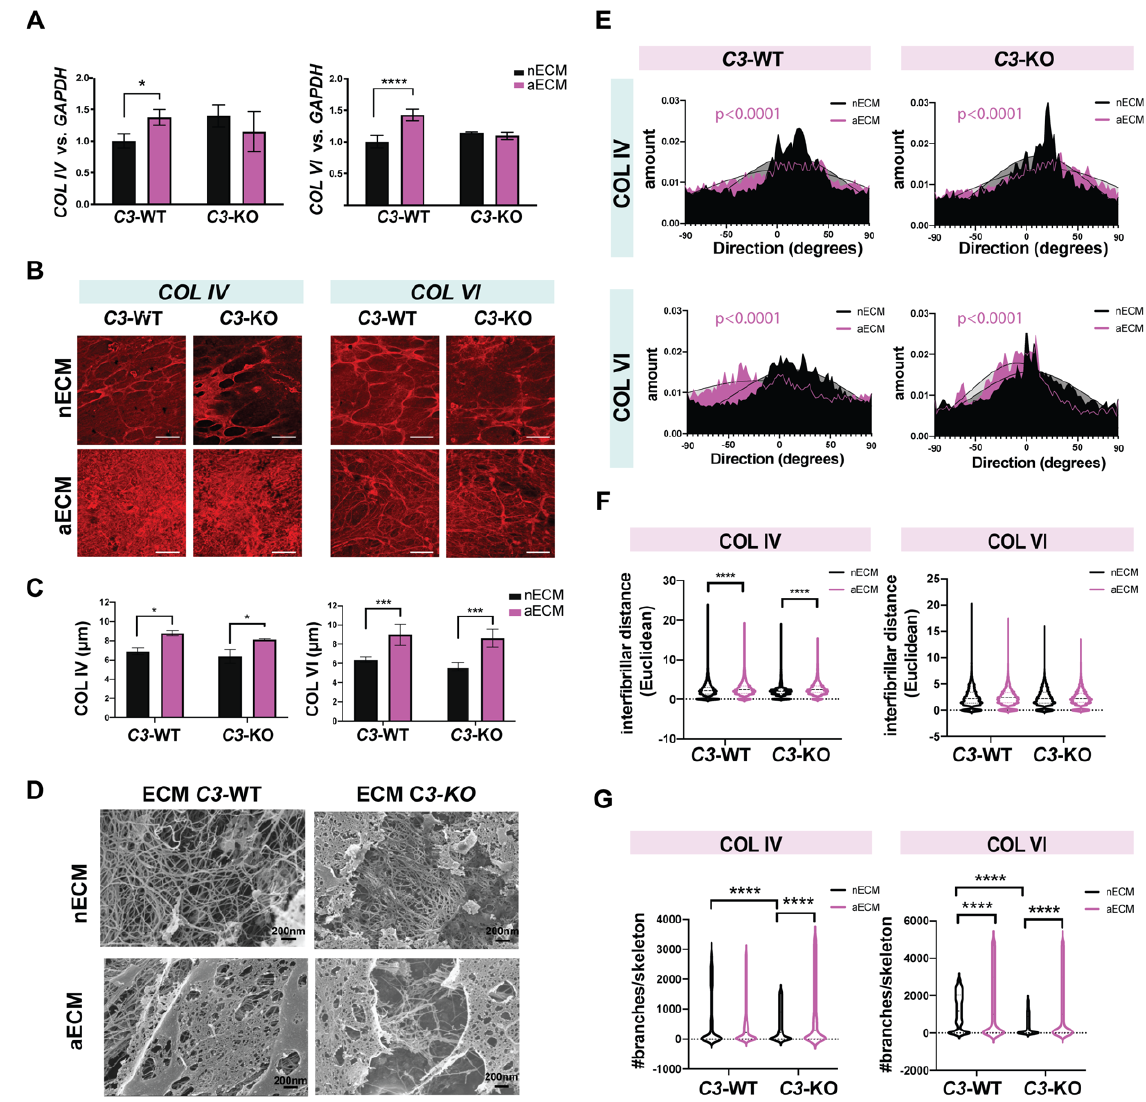
Figure 6. AMD-like substrate impairs the formation of the collagen meshwork. ( A ) mRNA levels of COL IV and COL VI normalized to GAPDH measured in iPSC-RPE cultures C3 WT/WT and iPSC-RPE C3 KO/KO grown on transwells coated with nECM and aECM for 20 weeks. ( B ) Representative confocal fluorescent microscopy images: top panels show the expression of collagen IV and collagen VI in iPSC-RPE cultures C3 WT/WT and iPSC-RPE C3 KO/KO after 20 weeks on transwells coated with nECM. Bottom panels show the extracellular deposition of COL IV and COL VI in decellularized transwells of iPSC-RPE cells C3 WT/WT and C3 KO/KO grown on AMD-like ECM (aECM) for 20 weeks. Scale bar: 25 µ m. ( C ) Thickness of collagens layers were measured with confocal using 0.13 µ m planes and are plotted in the graphs. Data represented as mean ± SD. N = 3 replicates, 2-way ANOVA, * p < 0.05, *** p < 0.001. ( D ) Scanning electron micrographs of the ECM deposited by iPSC-RPE cells C3 WT/WT and C3 KO/KO cultured on nECM and aECM after 20 weeks. ( E ) Directionality of the collagen fibers of representative immunofluorescent images was plotted. Gaussian distributions of cultures on nECM (black) and aECM (pink) were compared using their best fit values in a linear regression and are indicated in the graph with a black line. Distribution was significantly different between substrates for both genotypes (COL IV: C3 WT/WT nECM vs. C3 WT/WT on aECM, p < 0.0001; C3 KO/KO nECM vs. C3 KO/KO on aECM, p < 0.0001; COL VI: C3 WT/WT nECM vs. C3 WT/WT on aECM, p < 0.0001; C3 KO/KO nECM vs. C3 KO/KO on aECM, p < 0.0001). ( F ) The interfibrillar Euclidean distance (tortuosity) was measured for COL IV and COL VI fibers using FIJI and the BoneJ plugin. (One-way ANOVA–Kruskal–Wallis, **** p < 0.0001). ( G ) Violin plots show the branch lengths of collagen skeletons that were defined with